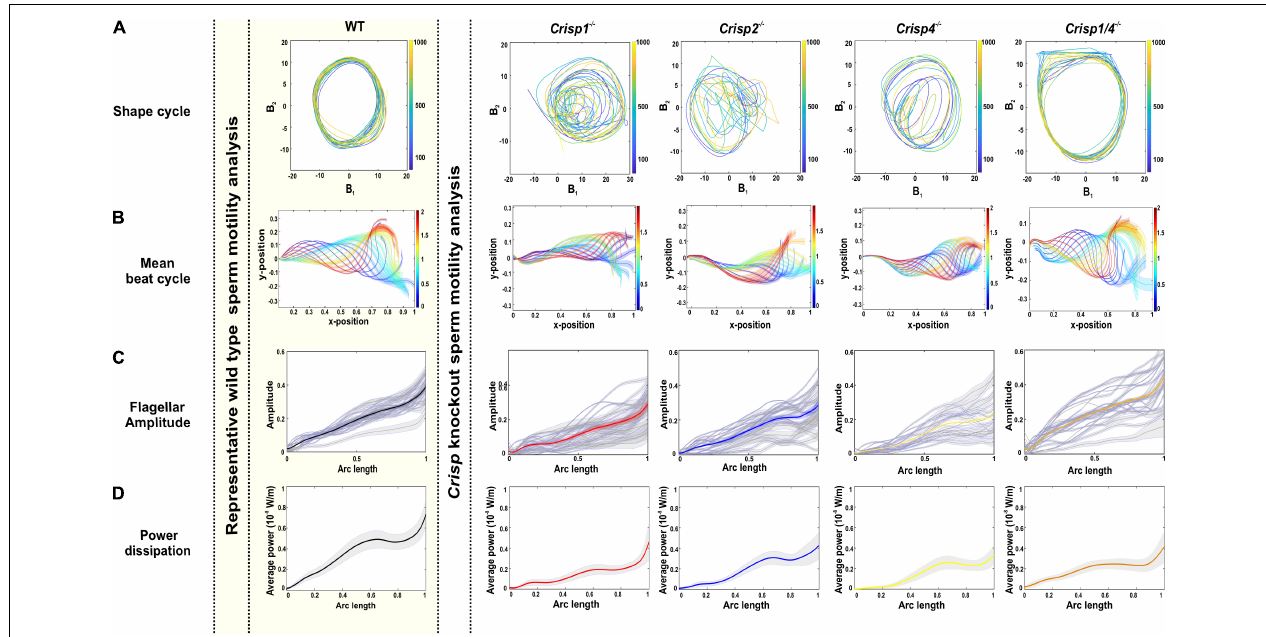
FIGURE 3 | Effects of loss of CRISP1, CRISP2, CRISP4, and CRISP1/4 on sperm flagellar beating pattern. (A) The representative shape cycles of the flagellar beating across Crisp knockout mice. (B) Reconstruction of mean beat cycle of sperm across knock out mouse genotypes. N = 25–30 sperm/genotype were analyzed, and representative mean beat cycles are shown. The color spectrum represents the non-dimensional time scale. (C) Analysis of flagellar beating amplitude from sperm from individual knock out mouse genotypes. Gray lines indicate the flagellar amplitude of individual sperm and the respective bold lines indicate the mean flagellar amplitude. Crisp1 − / − data is red, Crisp2 − / − data is blue, Crisp4 − / − data is yellow and Crisp1/4 − / − data is orange (D) Analysis of power dissipation (10 − 8 W/m) along the flagella. The bold line indicates averaged data across the sperm population ± SEM indicated in gray zone. Mouse genotype is indicated above each column. For simplicity, Crisp1 wild type data is shown as representative data for all wild types (within the shaded yellow box). Crisp1 − / − data is red, Crisp2 − / − data is blue, Crisp4 − / − data is yellow and Crisp1/4 − / − data is